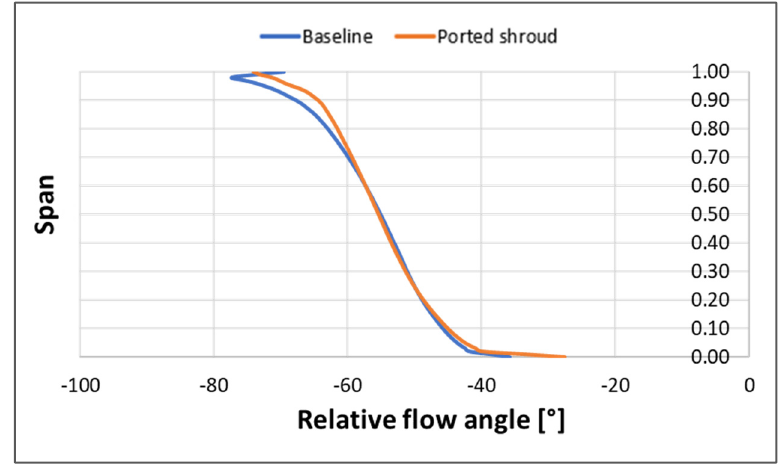
Figure 17. Comparison of the hub-to-shroud distribution of the relative flow angle at the leading edge between the configurations with ported shroud and baseline, at the best efficiency condition OP1.